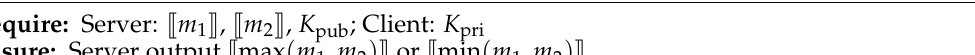
Algorithm 4 Secure comparison protocol.